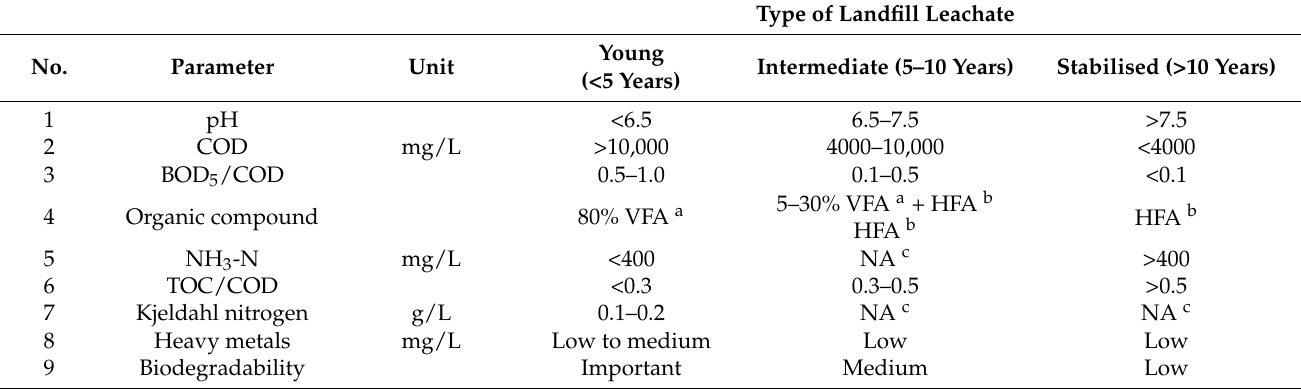
Table 1. Typical compositions of landfill